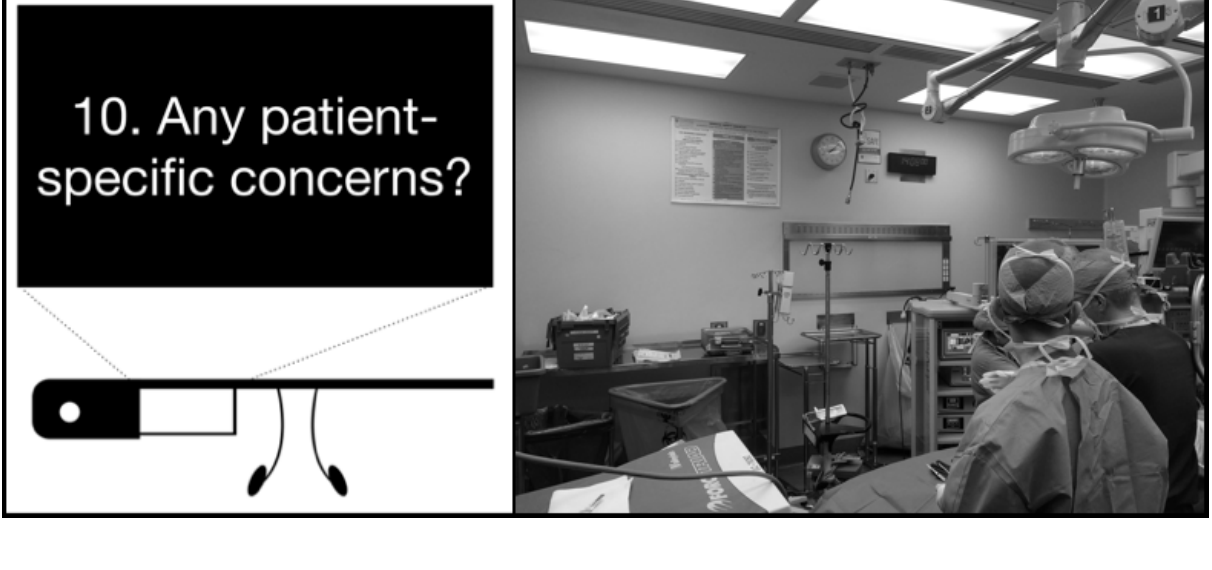
Table 2. Checklist completion rates by recall